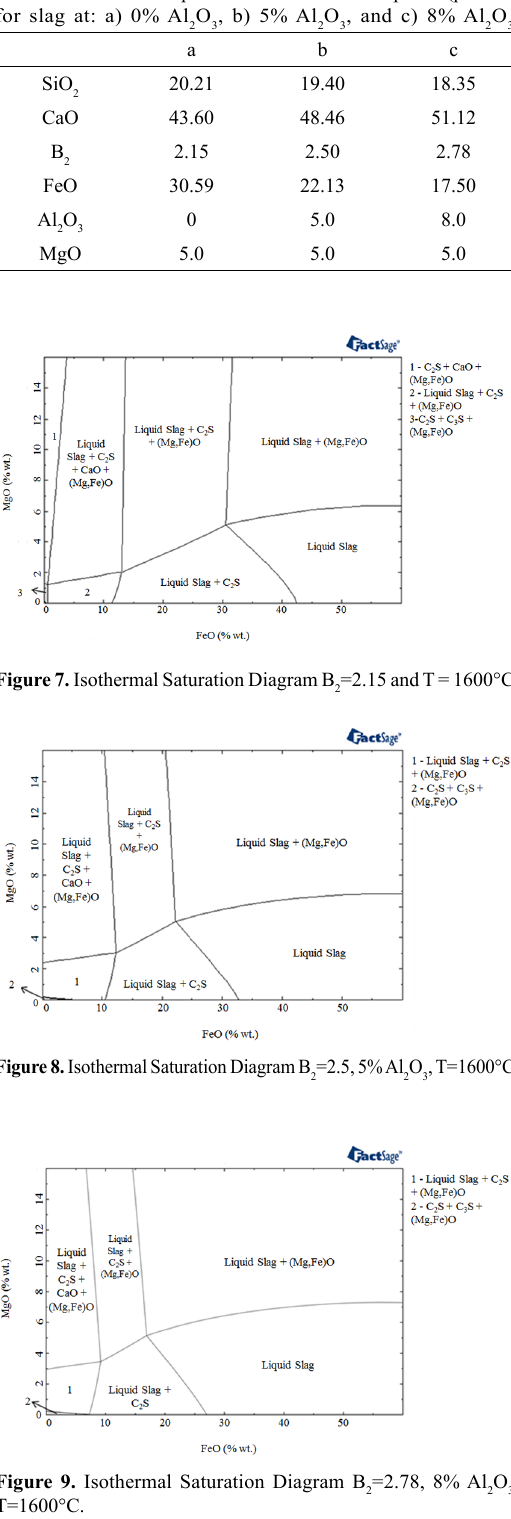
Figure 9. Isothermal Saturation Diagram B